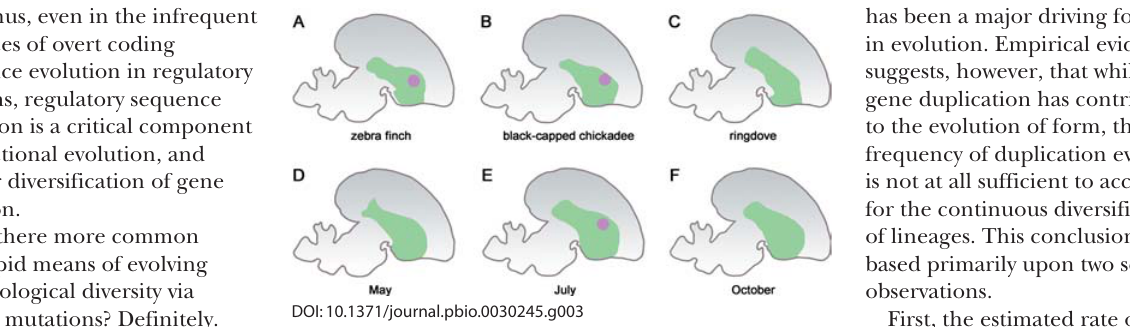
Figure 3. The Regulatory Evolution of FOXP2 and the Origins of Vocal Learning (A–F) The patterns of FOXP2 expression in sections of bird brains are depicted The green area is the striatum. FOXP2 is upregulated in the vocalization center known as Area X (pink spots) in vocal-learning species such as the zebra fi nch (A) and black-capped chickadee (B) but not in non-learning species such as the ringdove (C). (D–F) In the canary, FOXP2 expression in Area X varies over seasons; elevated expression is associated with periods during which the song is plastic (pink spot). (Figure based on